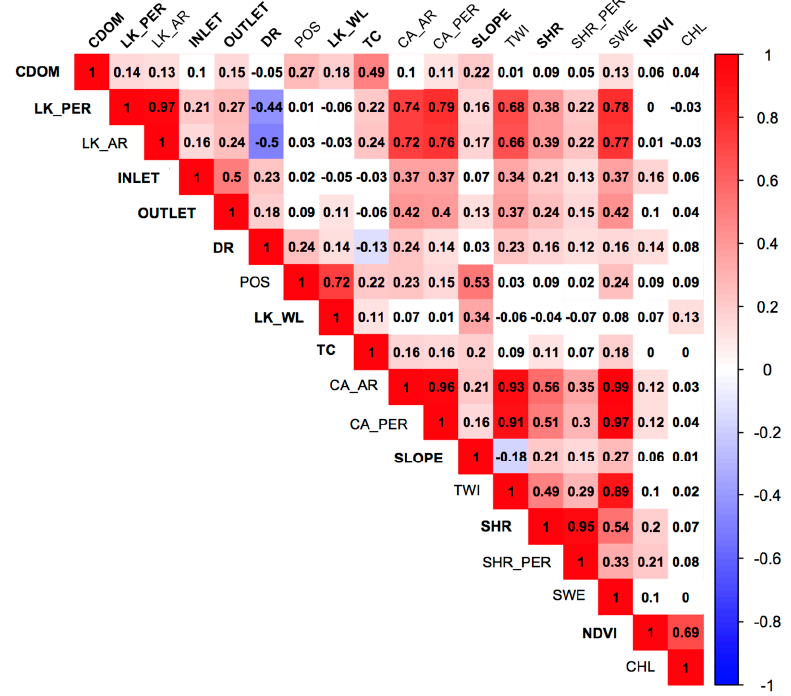
Figure 3. Correlation matrix of CDOM: lake and lake catchment dataset. Red color indicates positive relation of the parameters to CDOM, blue—inverse correlation. White color indicates correlations with p > 0.05. See Table 3 for variable codes. Variables used in the final statistical processing are shown in bold.